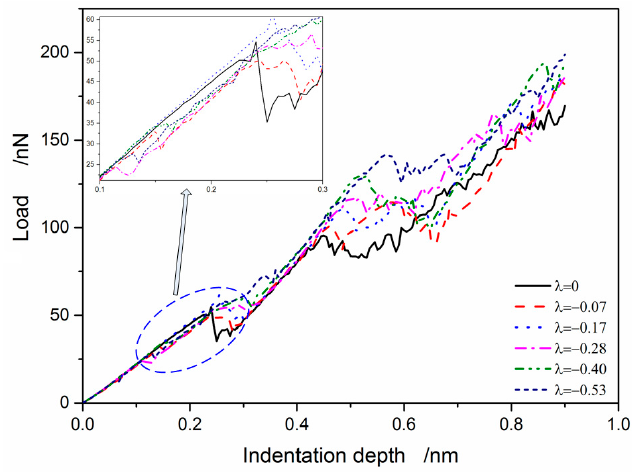
Figure 2. Load vs. indentation depth curves with different compressive residual stress.